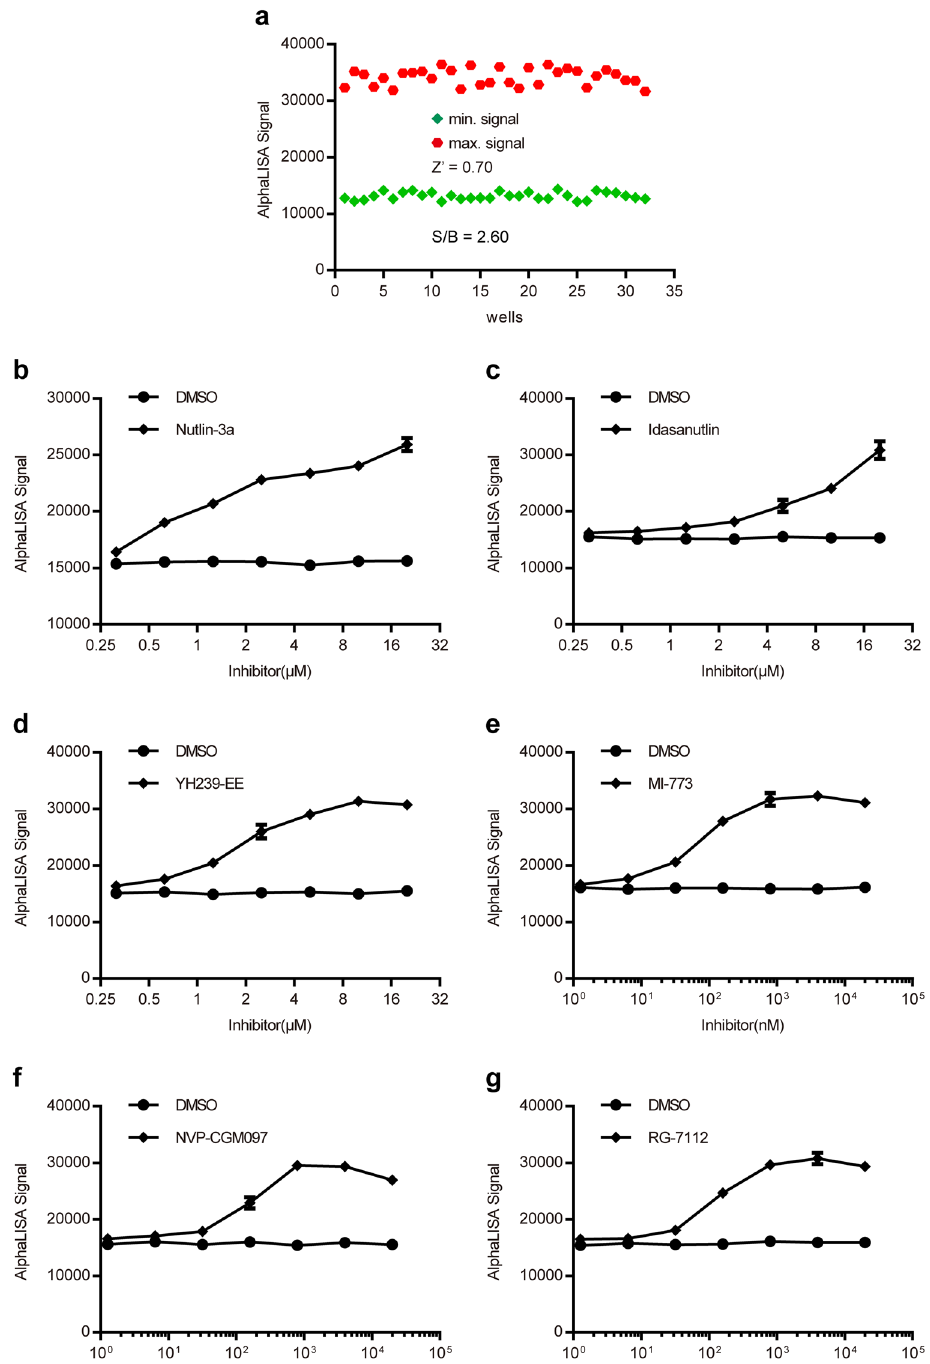
Figure 4. Development of an AlphaLISA based MDM2-inhibitor screening assay and pharmacological validation of the assay. ( a ) Robustness of the MDM2-inhibitor screening assay. AlphaLISA signals of 32 positive controls with optimal amount of cell extracts containing GST (max. signal) and 32 negative controls with the same amount of cell extracts containing MDM2-GST (min. signal) were plotted. ( b – g ) Dose-response curves for a few MDM2